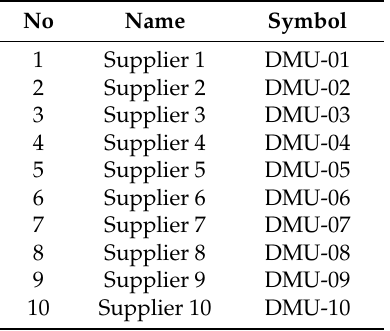
Table 3. The symbols of 10 gas and oil suppliers (DMU: Decision Making Unit).